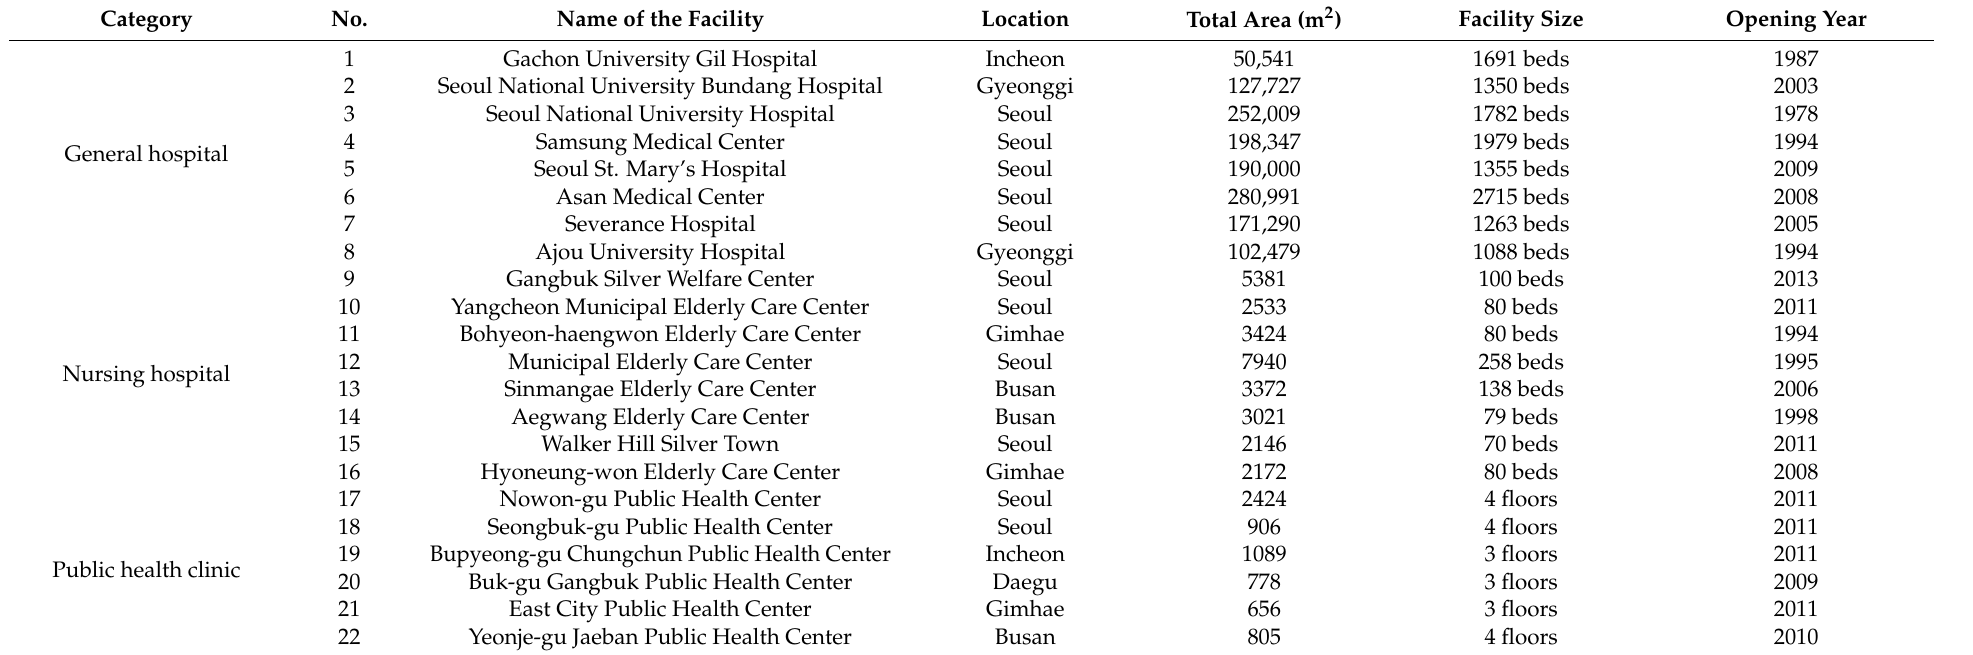
Table 4. List of public health facilities for environmental data